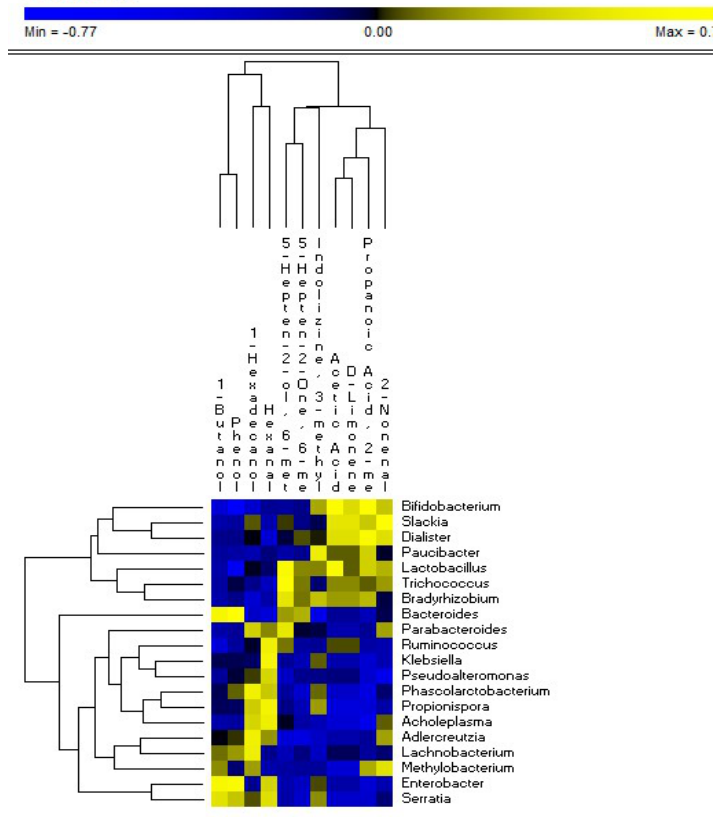
Figure 6. Significant correlations found between fecal microbiome and metabolome of lactose intolerant patients.